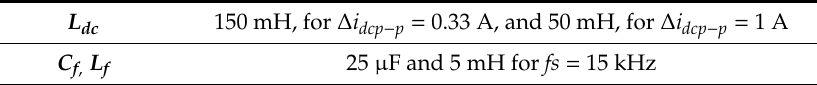
Table 2. Investigated system